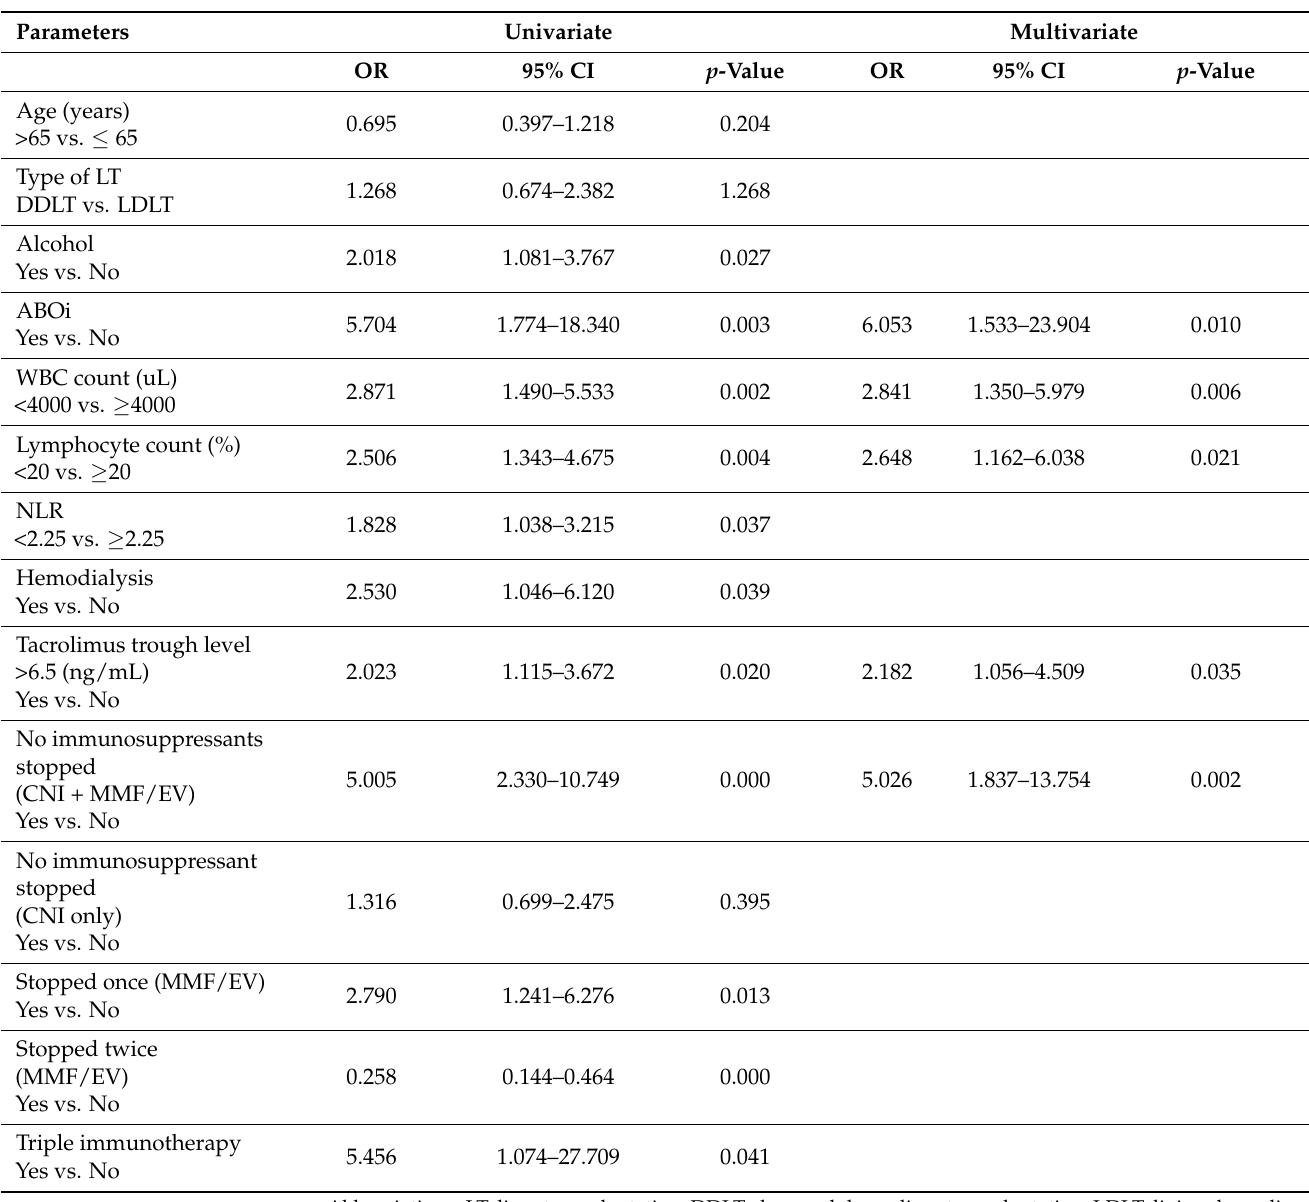
Table 2. Uni- and multivariate logistic regression model evaluating factors associated with vaccine